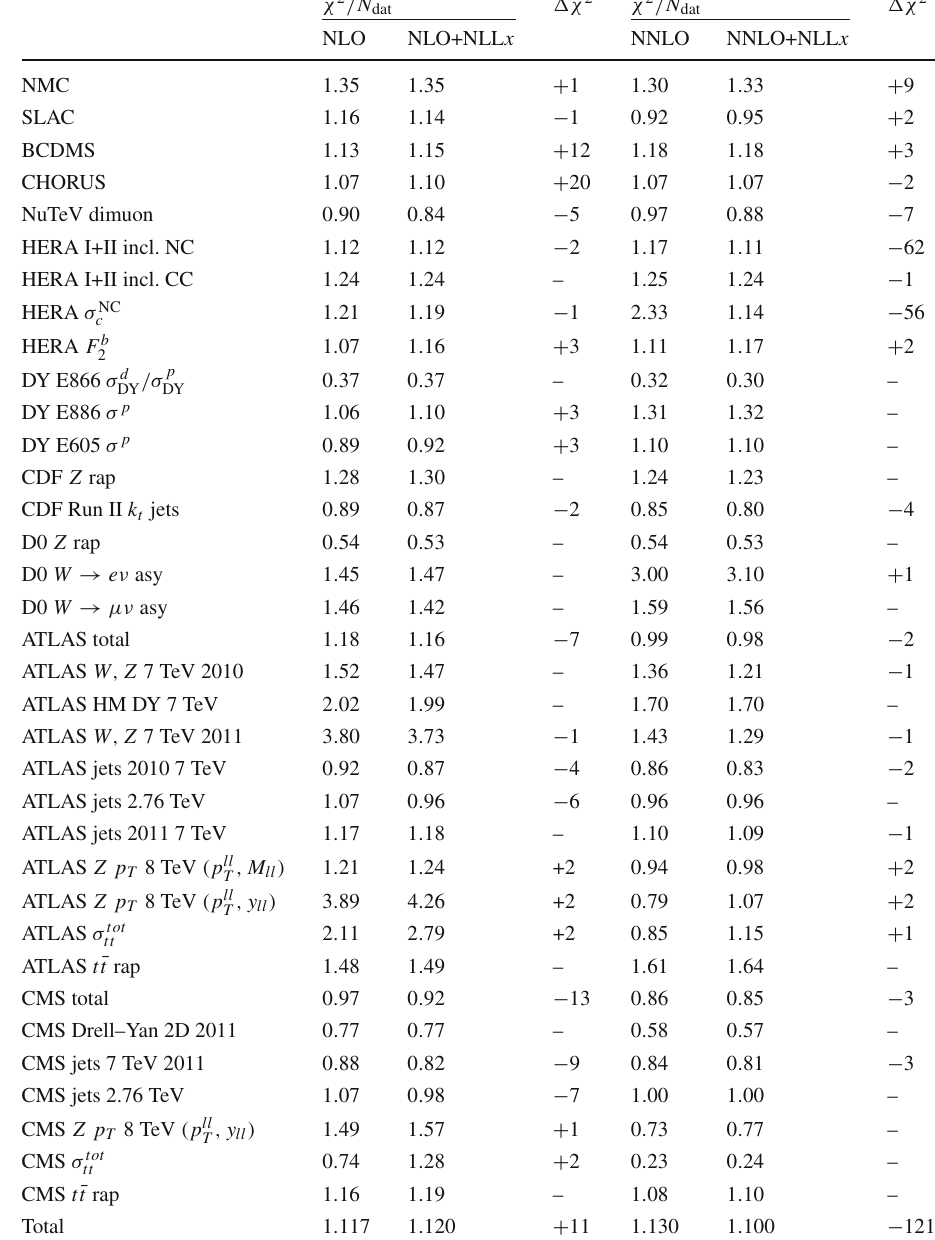
Table 4 Same as Table 3, now for the global NNPDF3.1sx NLO, NLO+NLL x , NNLO and NNLO+NLL x fits, corresponding to the baseline value of H cut = 0 . 6 for the cut to the hadronic